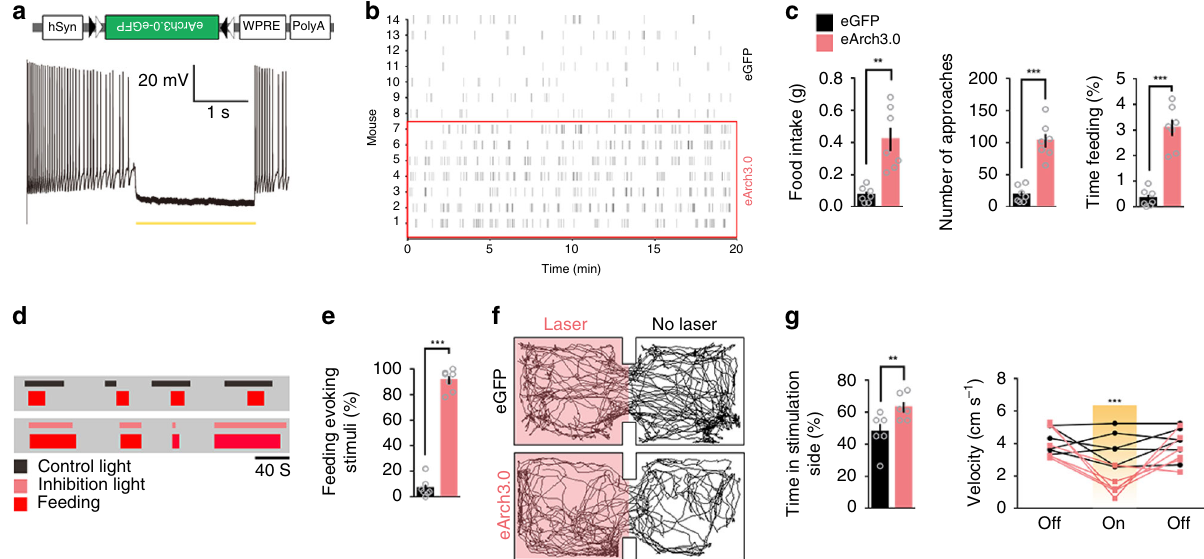
Fig. 3 Inhibition of the right aIC CamKII neurons promotes food intake. a Diagrams illustrating the injected virus (upper) and sample slice recordings from the aIC CamKII neurons expressing eArch3.0 (orange lines, 593-nm light) (lower). b Raster plot of feeding bouts in the fed mice expressing eArch3.0-eGFP in the caudal segment of the right aIC. c Total food consumption (left), number of approaches to food (middle) and the percentage of feeding time (right) were measured during a 20-min test ( n = 7 mice for each group, Two-tailed unpaired t test). d Raster plots showing feeding processes by one fed mouse in its home cage. Inhibition light (532 nm) and control light (644 nm) was triggered randomly. e The percentage of light stimuli (532 nm) that induces feeding ( n = 7 mice for each group, Two-tailed unpaired t test). f Representative locomotor trace of a mouse with the caudal segment of the right aIC CamKII neurons expressing eGFP or eArch3.0 that received photoinhibition in the laser compartment. g Percentage of time spent (left) and locomotor activity (right) in laser or no laser sides ( n = 7 mice per group, Two-tailed unpaired t test). * P < 0.05; ** P < 0.01; *** P < 0.005. Data are presented as means ± SEM. Source data are provided as a Source Data fi contrast, drinking (two-tailed unpaired t test, t test, water intake, (two-tailed unpaired t test, t 12 = 0.569, P = 0.5799, Supplemen- t 12 = 1.96, P = 0.0737; number of licks, t 12 = 1.503, P = 0.1587; tary Fig. 6a, b) or those in the right posterior IC (pIC) (two-tailed time drinking, t 12 = 0.1523, P = 0.1523, Supplementary Fig. 7b), unpaired t test, t 13 = 0.5801, P = 0.5718, Supplementary Fig. 6c – e) and observed that photoactivation of the CamKII + neurons in mating (two-tailed unpaired t test, t test, t 34 = 1.335, P = 0.1908, these two neighboring sites has no effect on feeding behavior. tary Fig. 7d – g, Two-tailed unpaired t test, for Supplementary Fig. 7e, open arm entries, t 12 = 0.6325, P = 0.539; time in open arm, t 12 = 0.874, P = 0.3993, for Supplementary Fig. 7g, time in center, t 12 = 1.037, P = 0.3202; velocity, t 12 = 1.078, P = 0.3022) were unaffected. Taken together, these results indicate that the inhibition of the CamKII + neurons in the caudal segment of